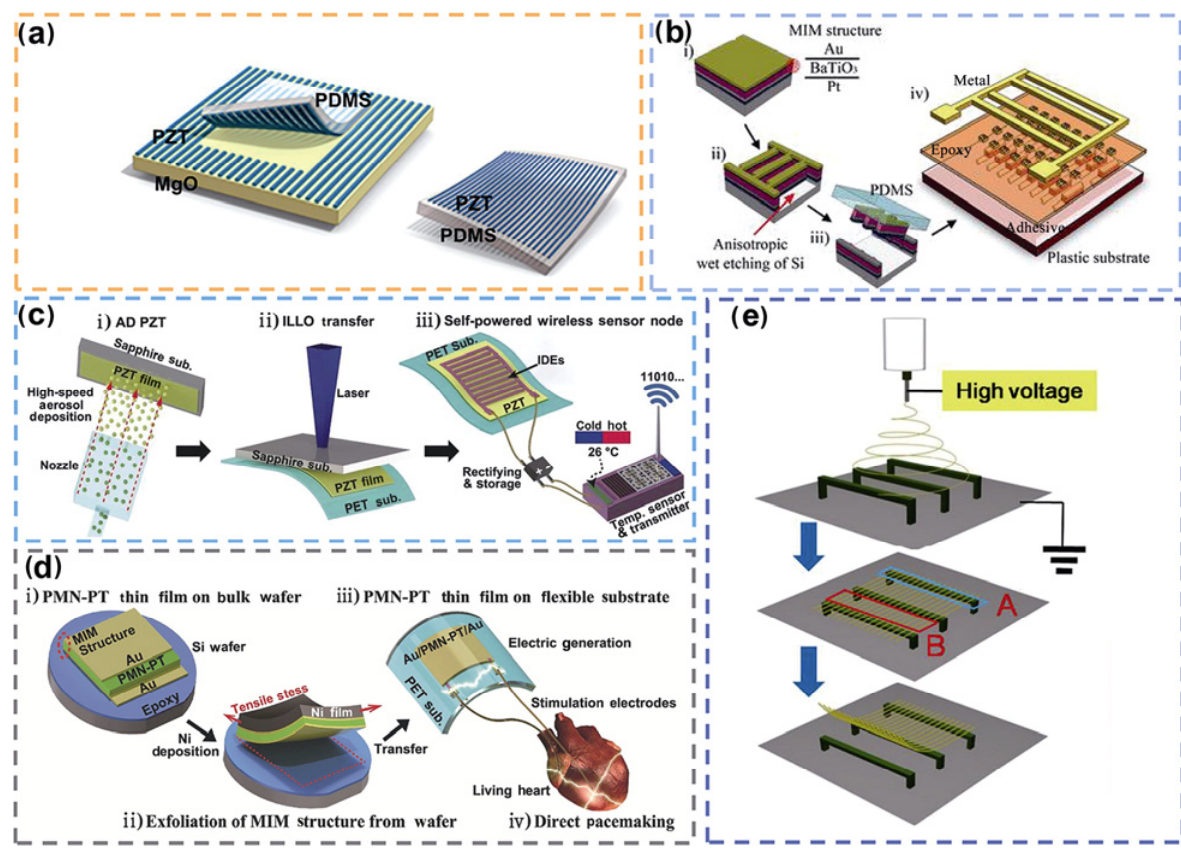
Fig. 8 (a) Transfer printing of PZT ribbons onto flexible rubber substrates. (b) Schematic illustration of process for fabricating flexible BTO nanogenerator on plastic substrates. (c) Schematic illustration of device-fabrication process and self-powered wireless sensor network using flexible AD PZT energy harvester enabled by inorganic-based laser lift-off (ILLO). (d)